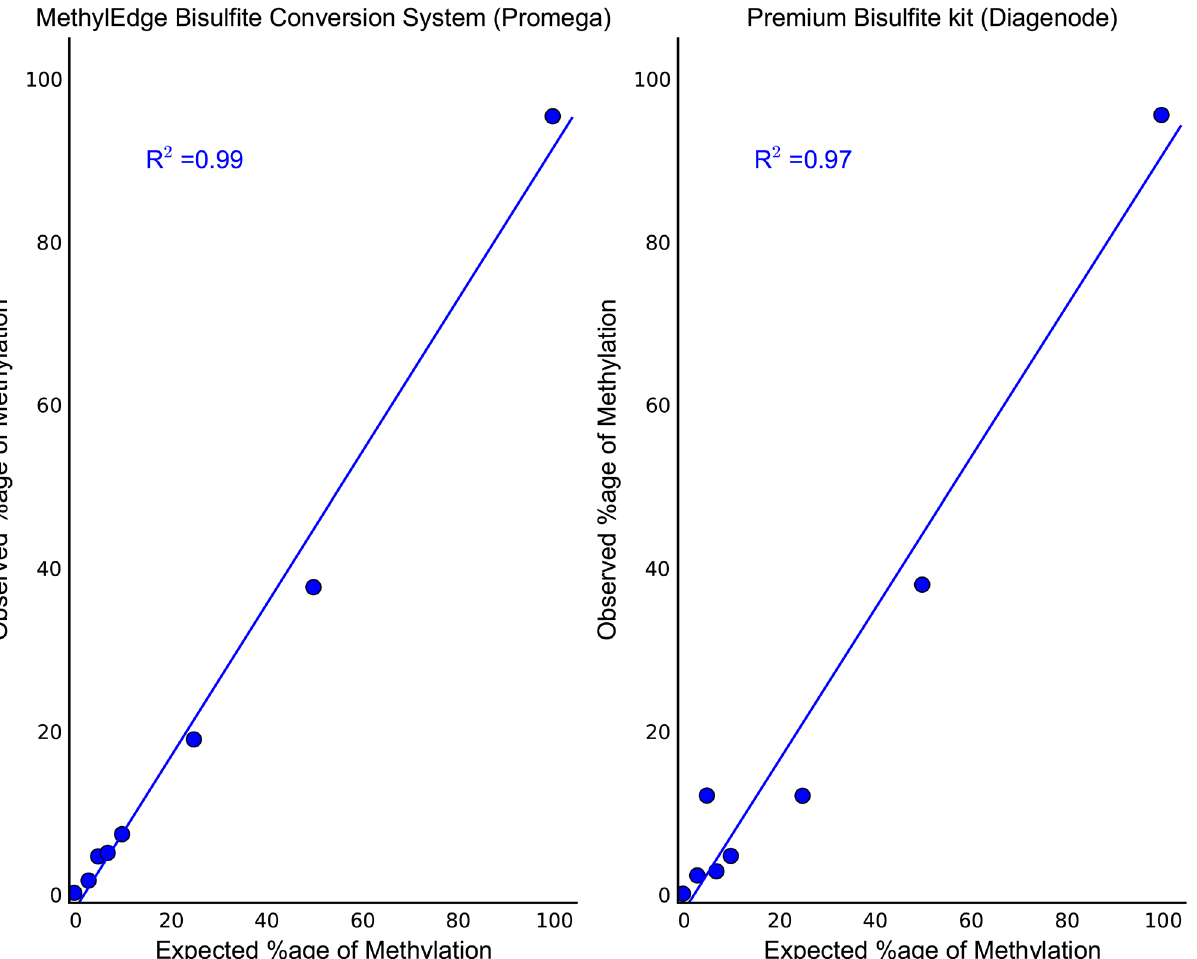
Fig 6. Bisulfite amplicon next generation sequencing. Standard curves were generated by next generation sequencing methylation quantification of known methylation level controls. The expected percentage of methylation was plotted versus the observed one. Points represent the mean methylation level of the fifteen CpG sites of the region as analyzed with BSMAP. Lambda-DNA control 1 was able to fit linear lines with both kits with R 2 values as presented [P value for both samples < 0.05].